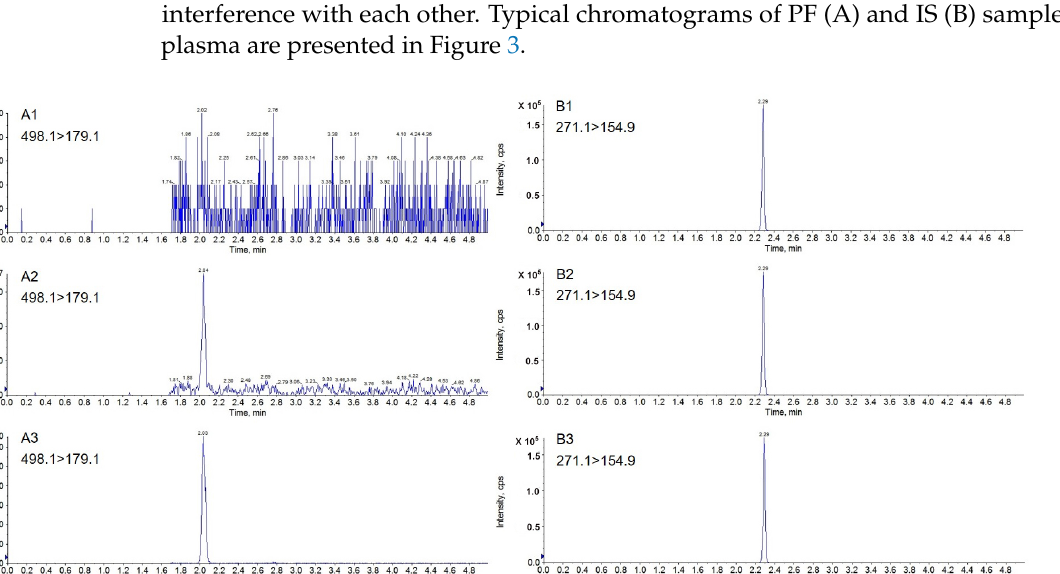
Table 3. Calibration curves of the LC-MS/MS method for PF in SD rat plasma. Nominal Conc. (ng/mL)